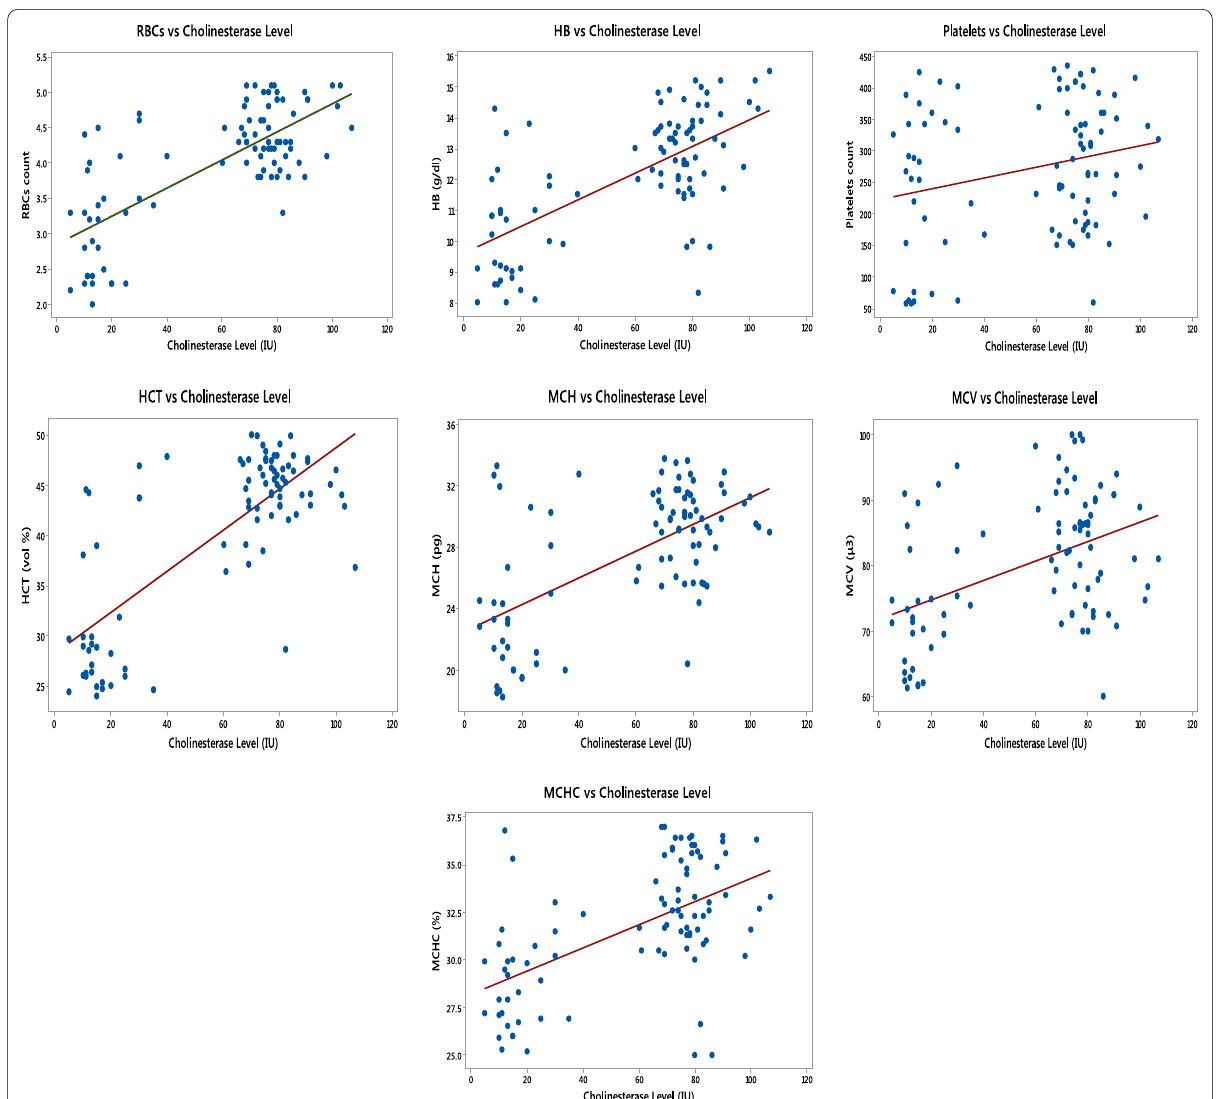
Fig. 2 Correlations of Cholinesterase level to the other measured laboratory parameters. Significance was set at p value less than 0.05